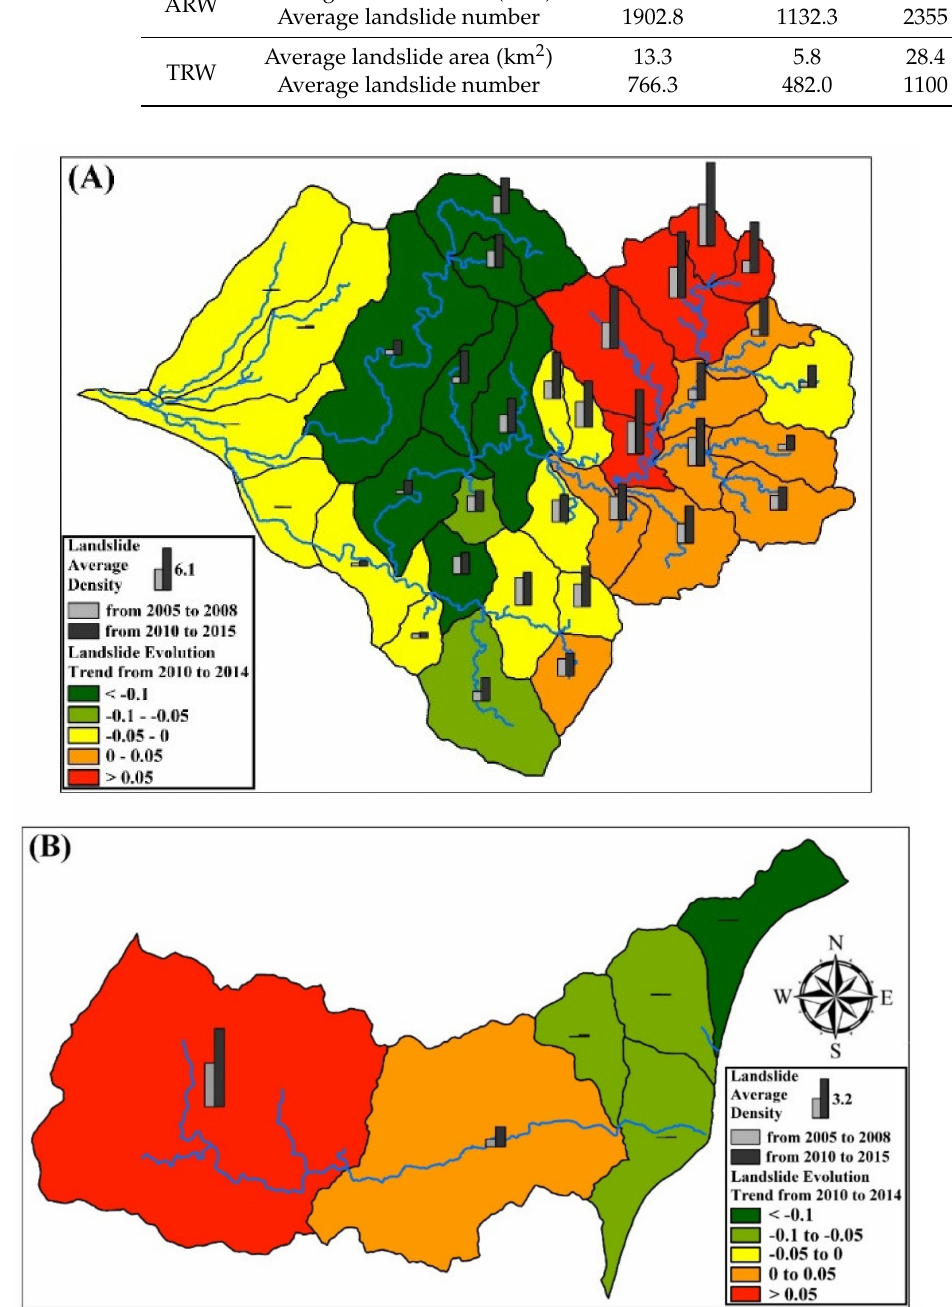
Figure 7. The average landslide density and landslide evolution trend index value from 2005 to 2015 in the ARW ( A ) and TRW ( B